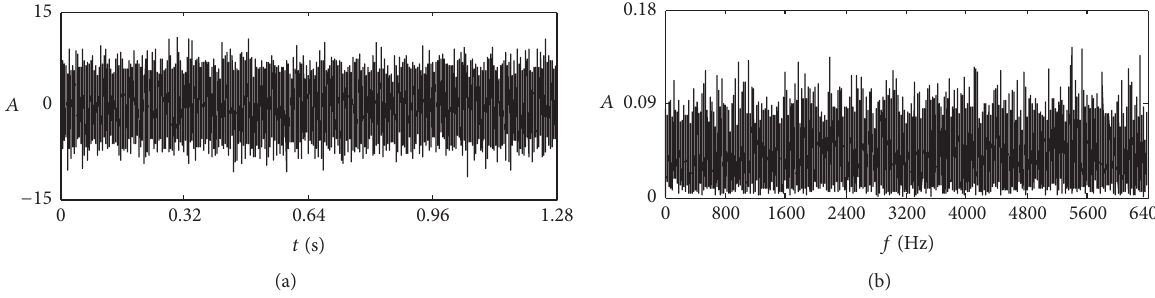
Figure 3: Simulation signal: (a) the original waveform; (b) the frequency